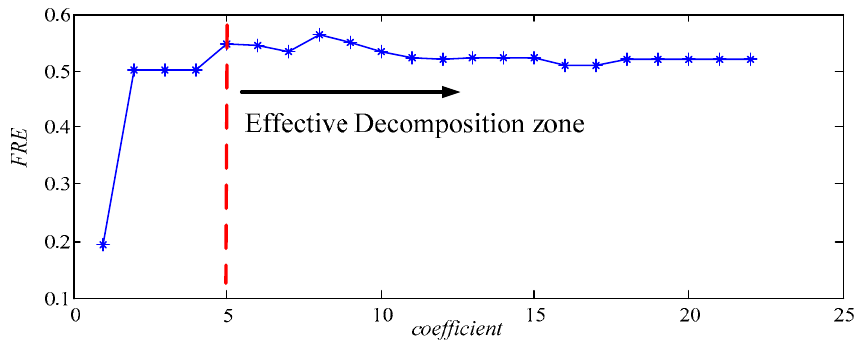
Figure 15. The FER value distribution diagram of all highest-order modes based on the loose slipper fault signal.